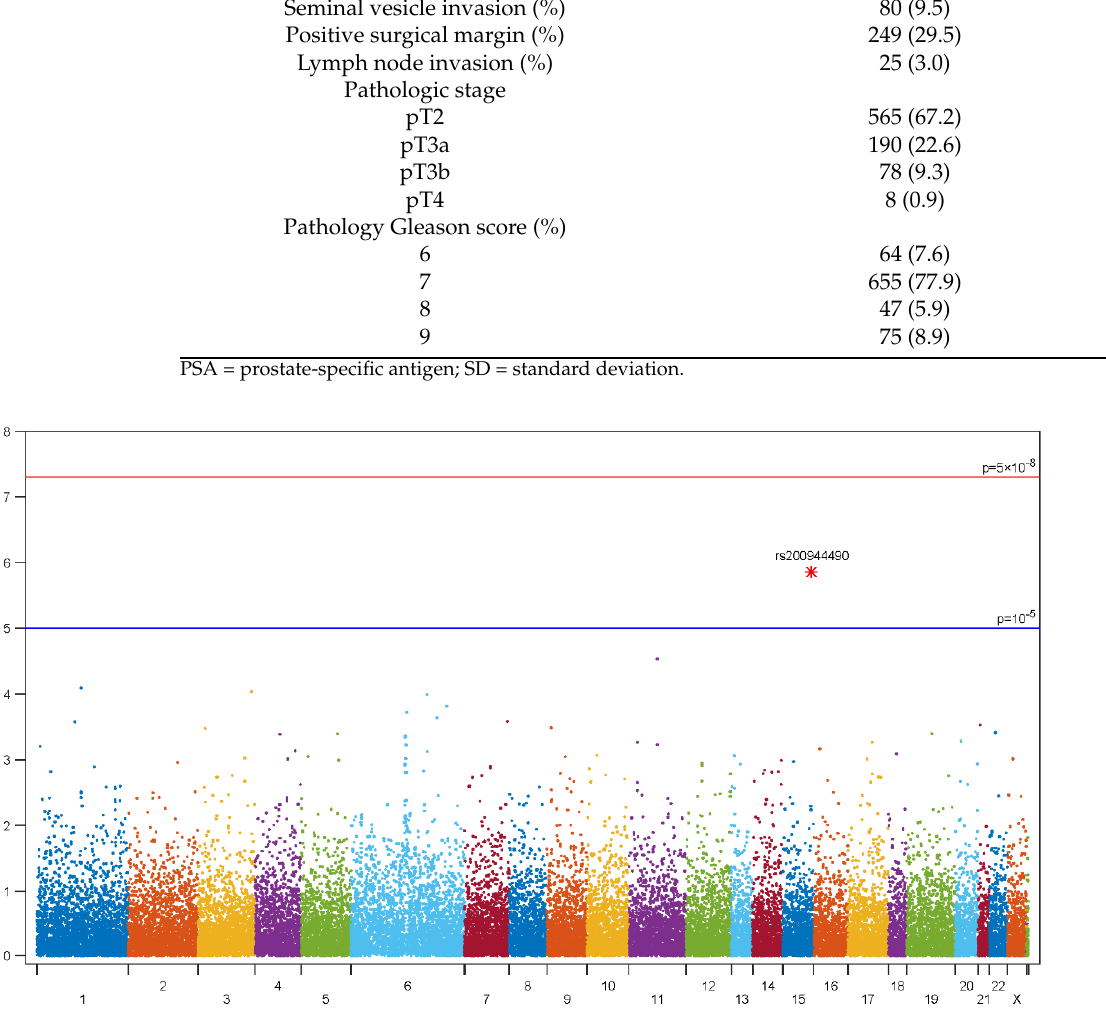
Among 242,221 single nucleotide polymorphism, 4 SNPs significant to high Gleason score. Abbreviations: SNP = single nucleotide polymorphism; OR = odds ratio; CI: confidence interval.